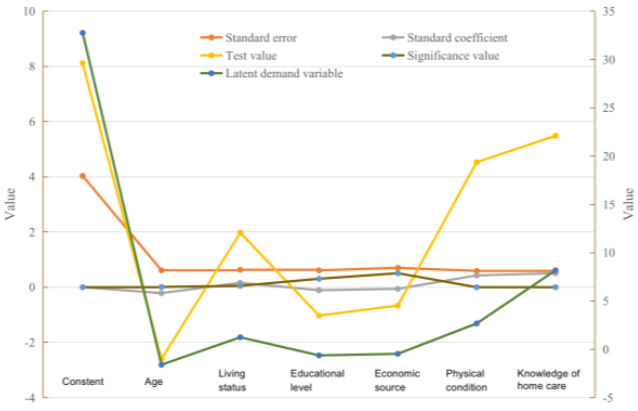
Figure 4. Analysis of the demand for elderly services under general conditions.